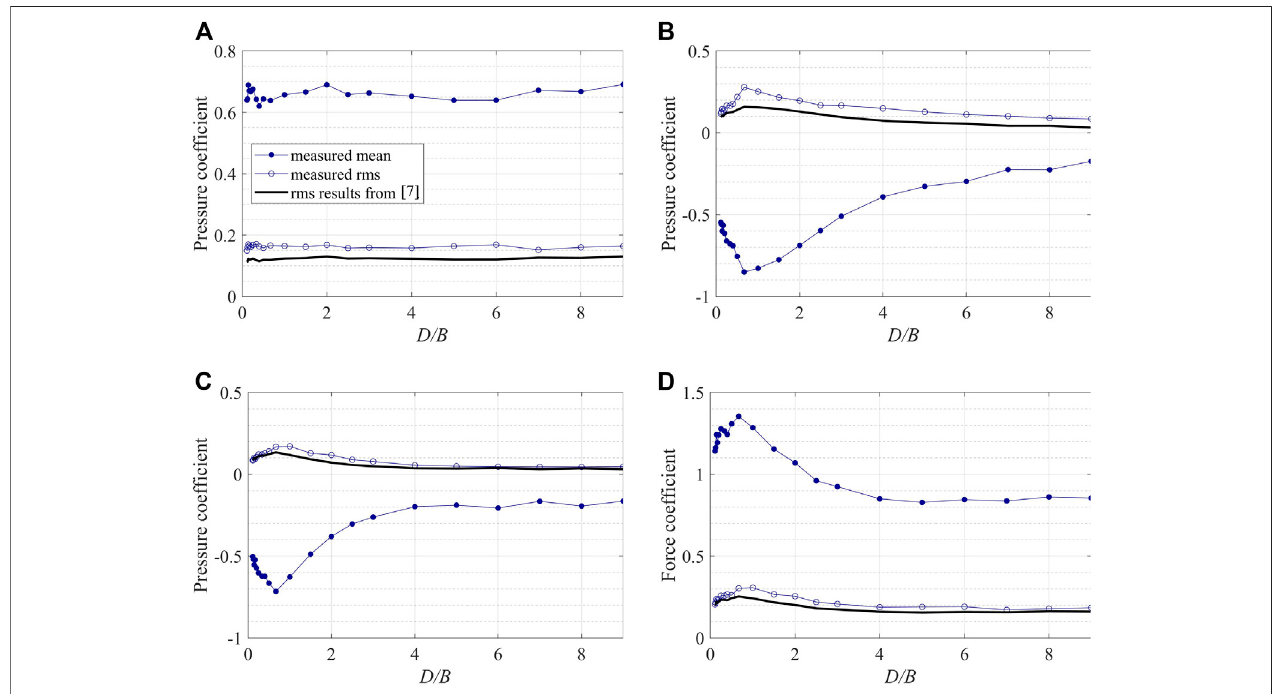
FIGURE 5 | Mean and rms area-averaged pressure coef fi cients on the (A) windward wall (B) side wall (C) leeward wall and (D) drag coef fi cients under the orthogonal wind direction and comparison with results from Solari (1993a).